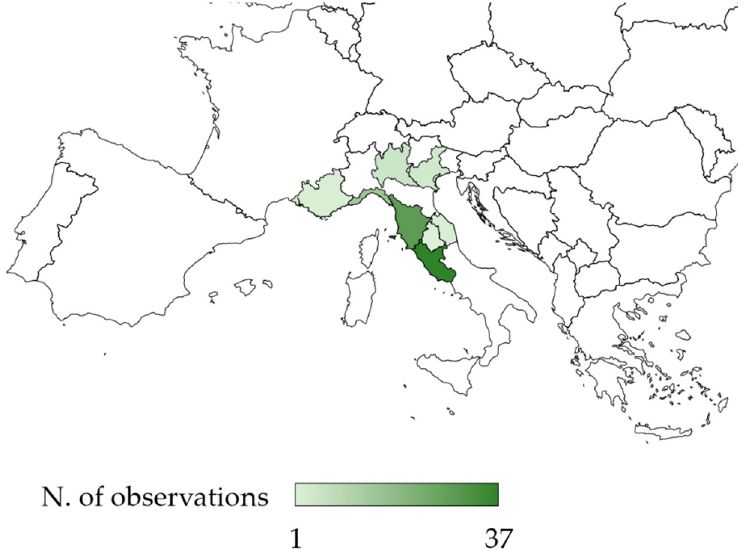
Figure 3. Map of the known occurrences of the black weevil Aclees taiwanensis in Southern Europe. (Bing Technology, © GeoNames, Microsoft, Tom Tom, Amsterdam, The